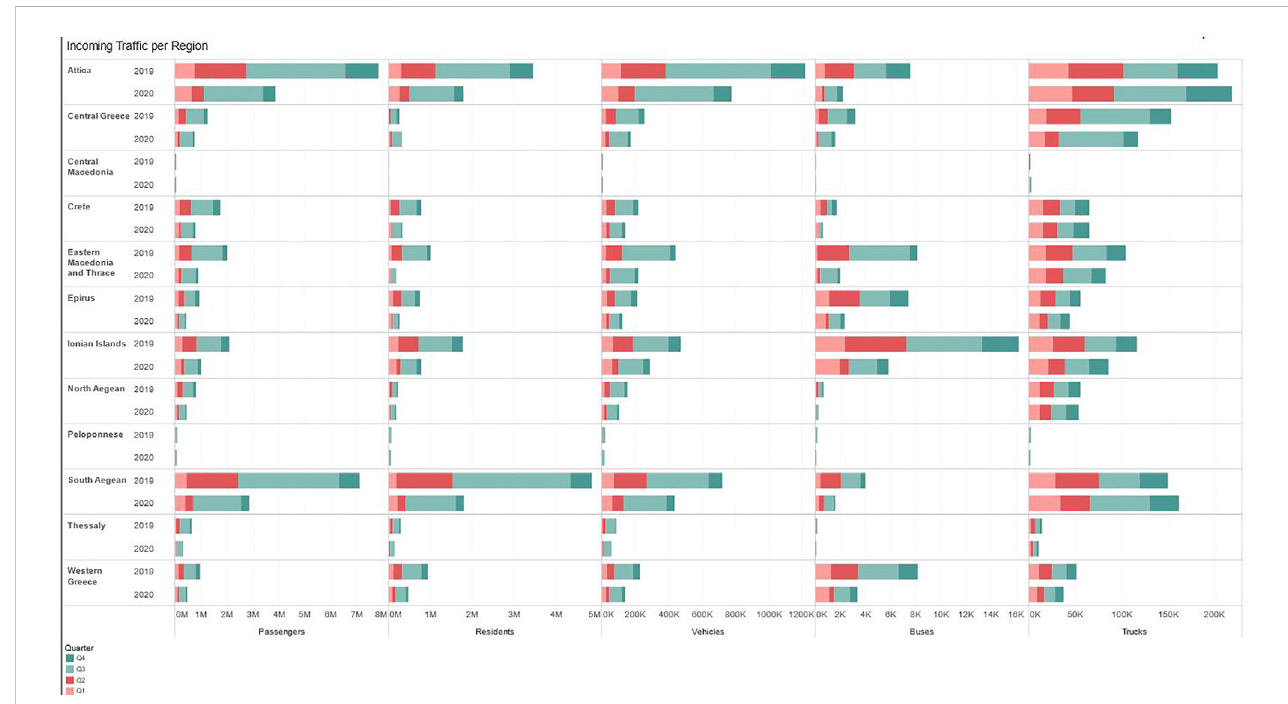
FIGURE 1 Incoming passenger and vehicle traf fi c per region per quarter (2019 and